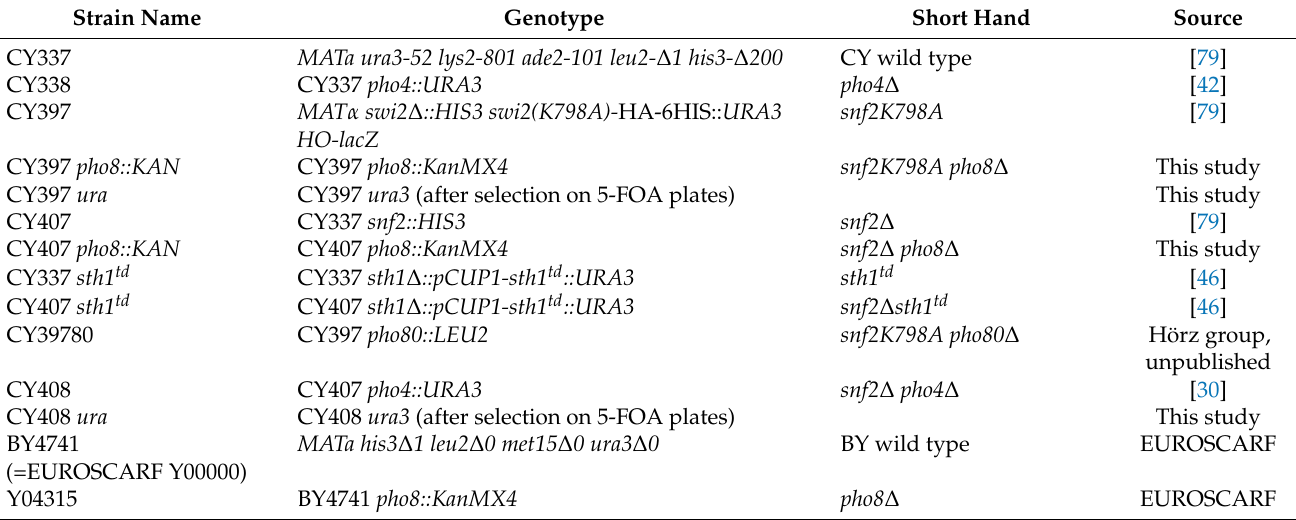
Table 2. Strains used in this